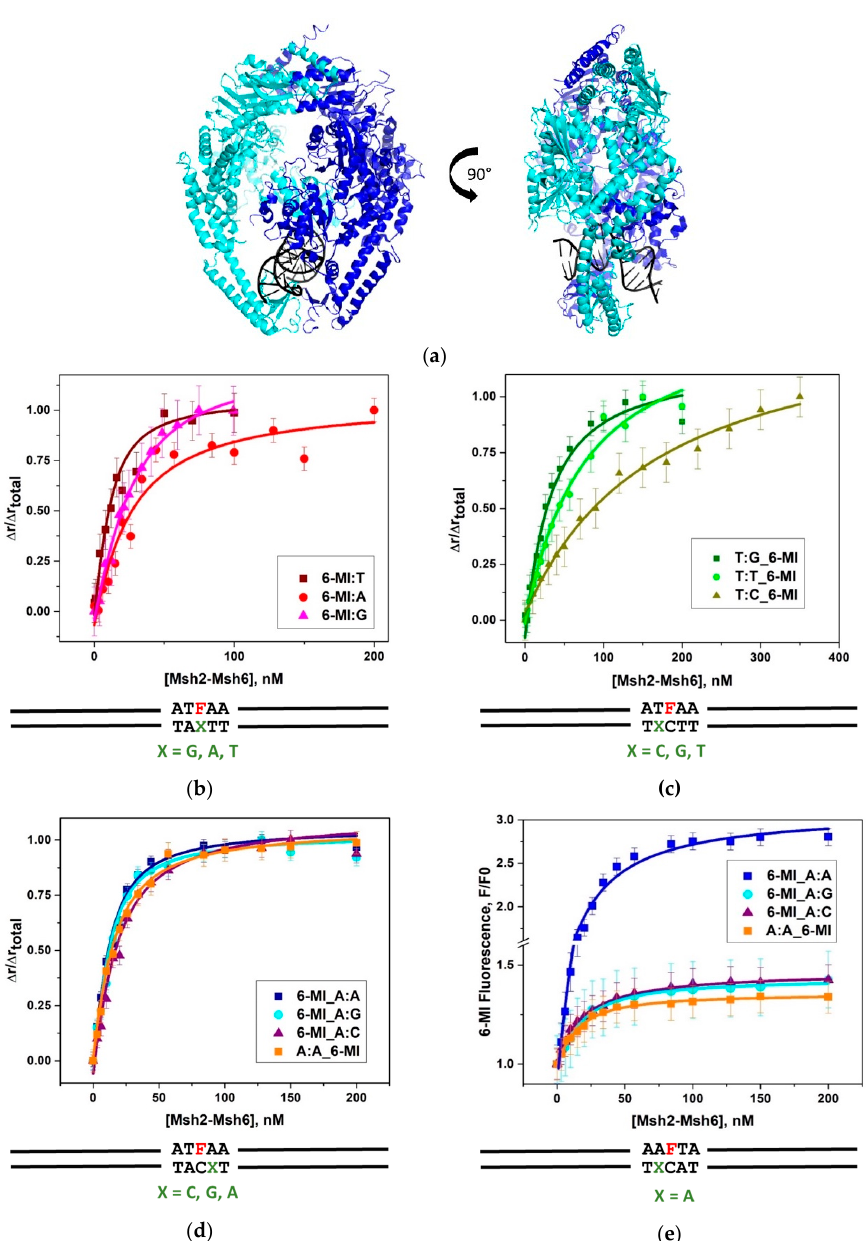
Figure 1. ( a ) Schematic of the Msh2-Msh6 protein in ribbon form showing both front and side views. Msh2 is shown in teal, Msh6 is shown in blue and the DNA is in black. The side view reveals protein-induced bending of the DNA (figure generated from 208B pdb file and Pymol software). Equilibrium fluorescence anisotropy binding curves of Msh2–Msh6 with ( b ) 10 nM 6-MI:X, where X = T, A, G; (c) 10 nM T:X_6-MI DNA substrates, where X = C, G, T; ( d ) 10 nM A:X_6-MI DNA where X = C, G, A (DNA sequences in Table S1); ( e ) fluorescence intensity increase of 6-MI_A:X duplexes upon Msh2-Msh6 binding. An intensity increase of approximately 200% is observed when 6-MI is located 5 ′ to the A:A mismatch. Samples were excited at 340 nm and emission was monitored at 430 nm, as described in the text. Error bars shown are determined from three independent